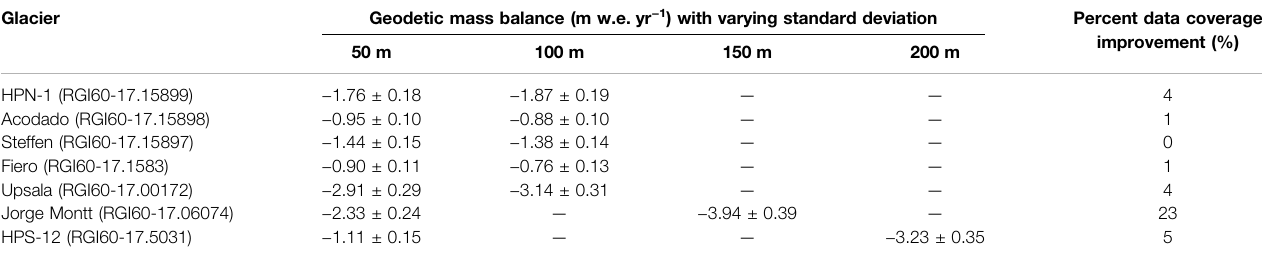
TABLE 2| Geodeticmassbalancesensitivitytomaximumstandard deviationallowed in2000 – 2020elevation trend.ForHPS-12, DEMswereco-registered totheCopDEM using higher elevation outlier threshold than other glaciers (see Section 2.1 ).